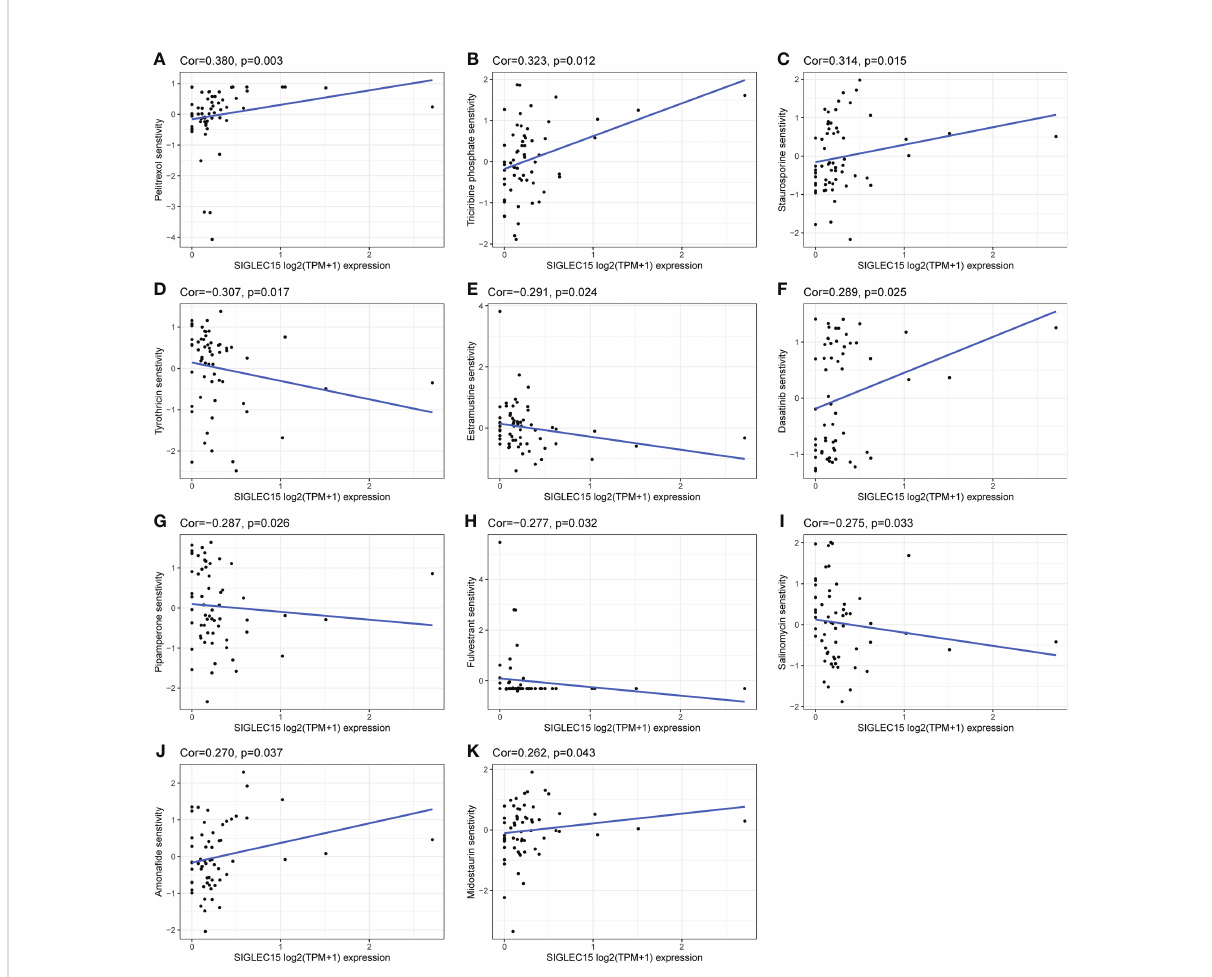
FIGURE 10 Potential effective chemotherapy drugs with SIGLEC15 . (A – K) Correlation of SIGLEC15 mRNA expression level and IC50 of different drugs based on the CellMiner